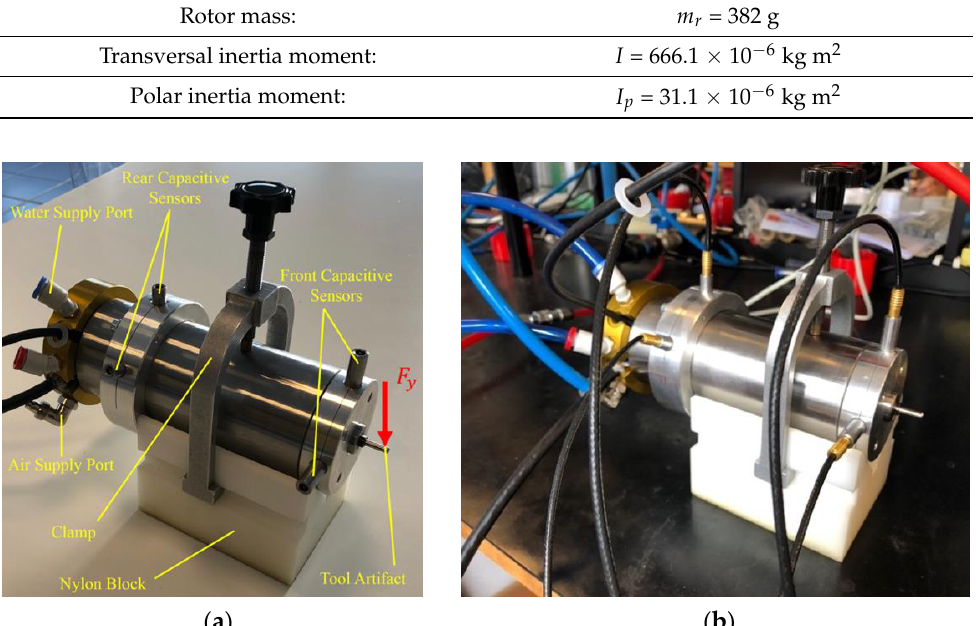
Table 1. Mass properties of rotor. Rotor mass: m r = 382 g Transversal inertia moment: